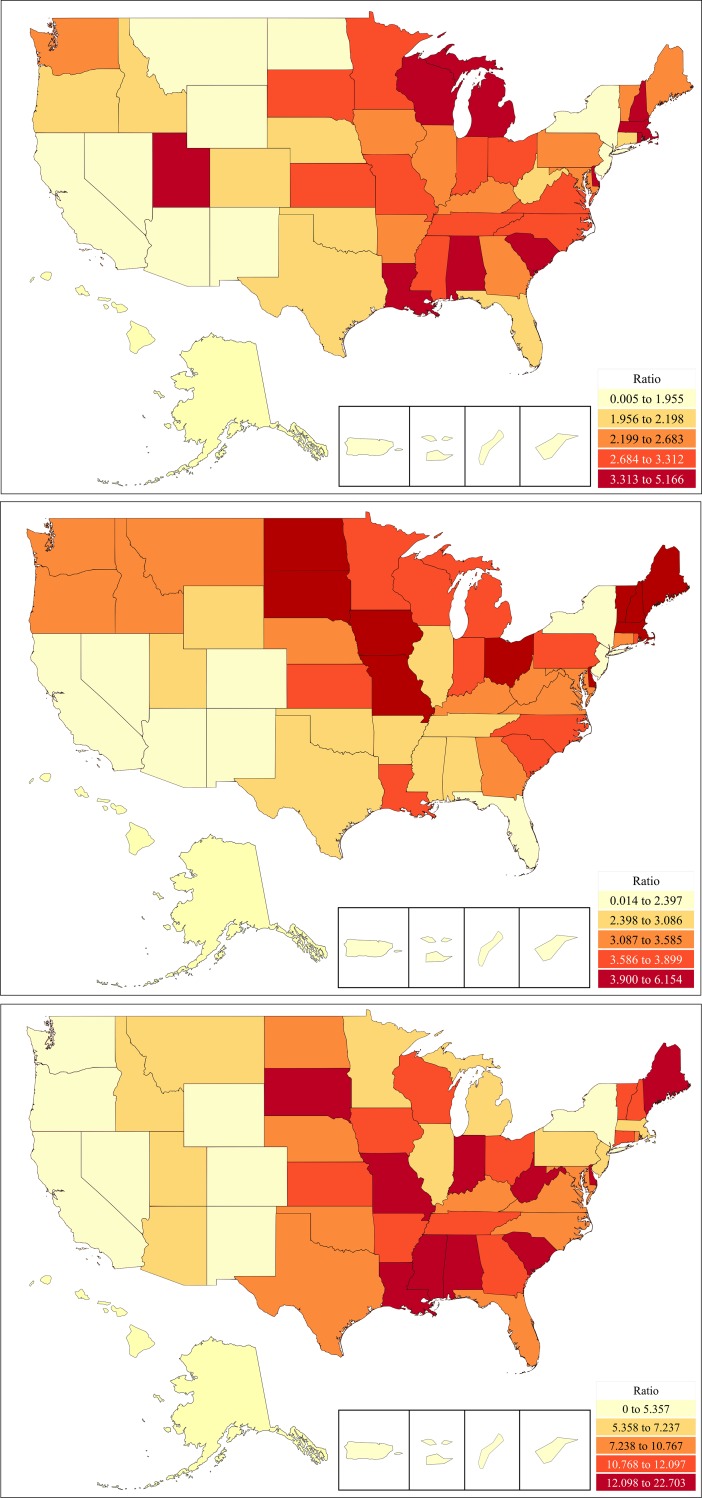
Heat map of per capita of amphetamine (A, top), methylphenidate (B, middle), or lisdexamfetamine (C, bottom) as reported to the Drug Enforcement Administration in 2016. Ratio relative to the lowest state (amphetamine = 25.52 mg/capita, methylphenidate = 19.70 mg/capita, lisdexamfetamine = 3.63 mg/capita).